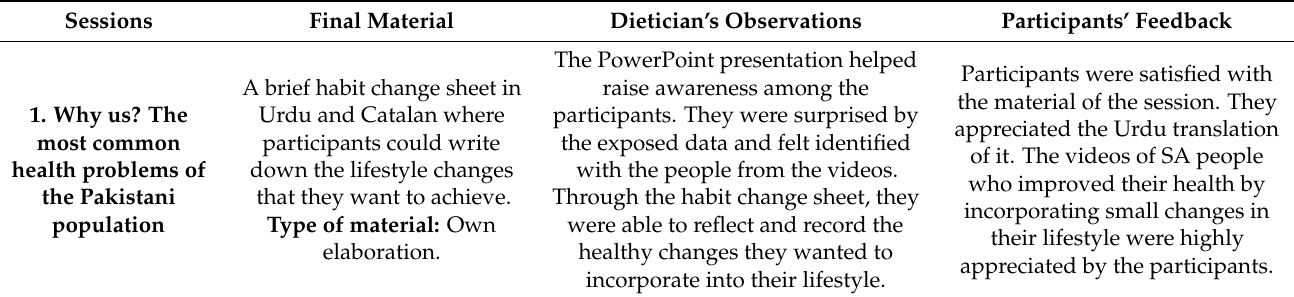
Table 2. Evaluation of the educational